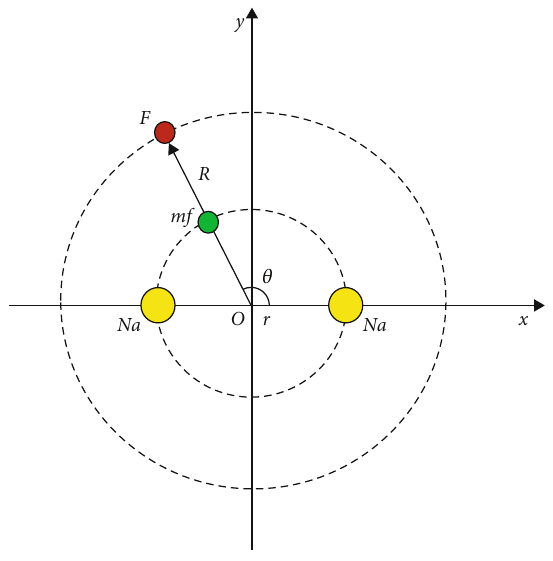
Figure 1: The coordinate system for calculation. Table 1: Parameters for the analytic PES of the Na